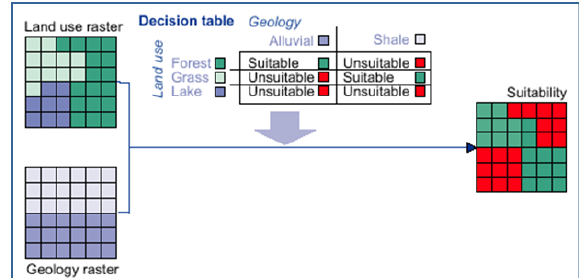
Figure 16. A typical example of raster analysis from two raster input of the same pixel size and covered